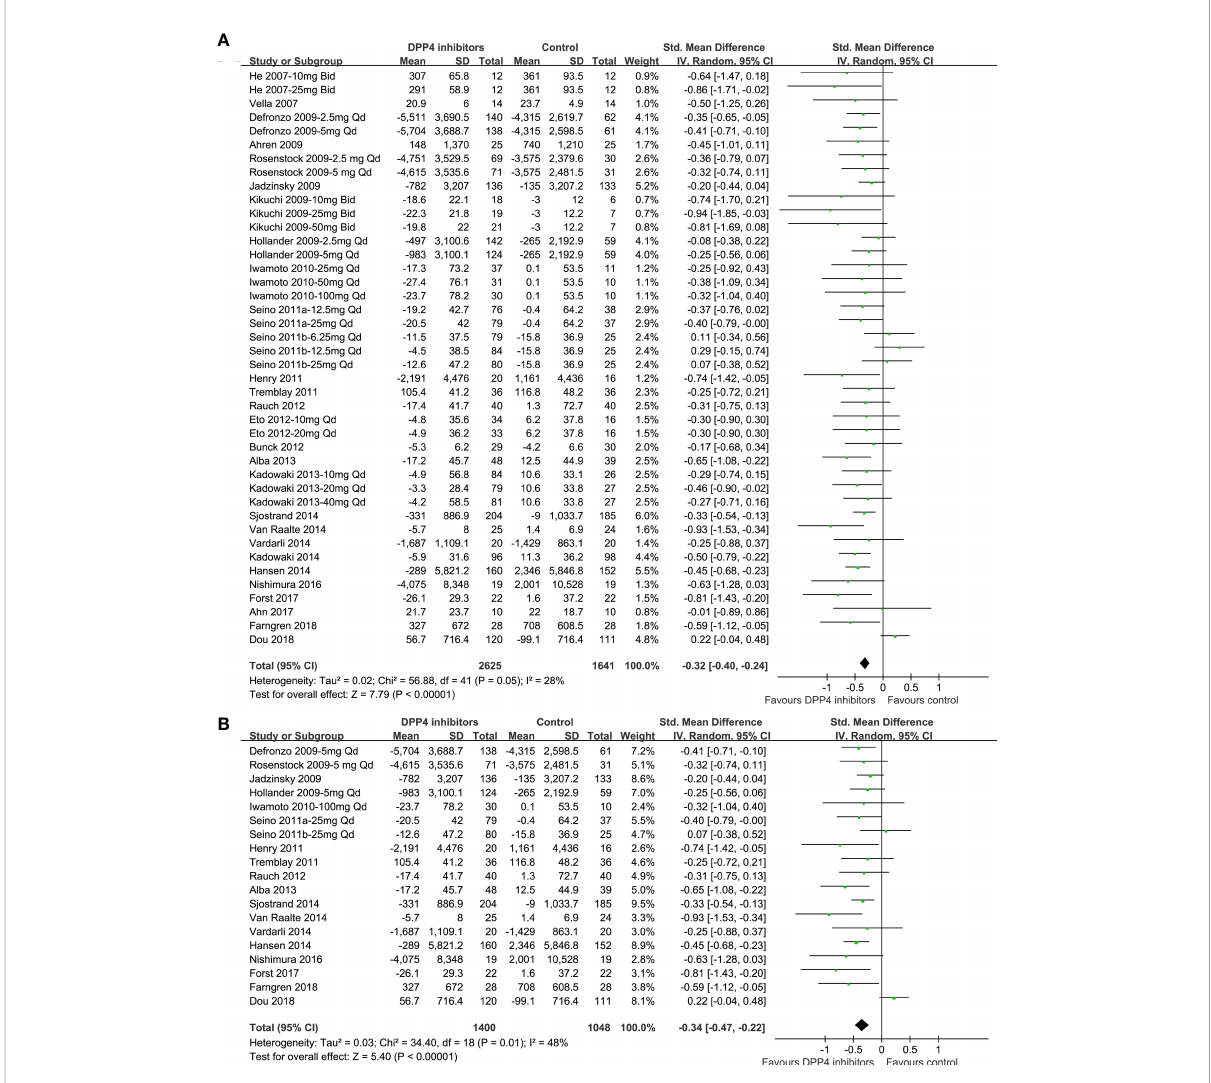
FIGURE 2 Forest plots for the meta-analysis comparing the effects of DPP4 inhibitors and placebo on circulating glucagon levels in T2DM patients. (A) Forest plots for the overall meta-analysis; and (B) forest plots for the sensitivity analyses limited to studies with FDA-approved DPP4 inhibitors and